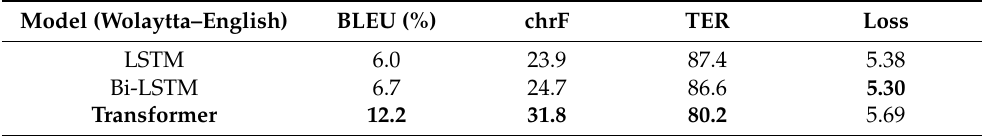
Table 4. BLEU, chrF, and TER scores of baseline models in Wolaytta–English translation. Model